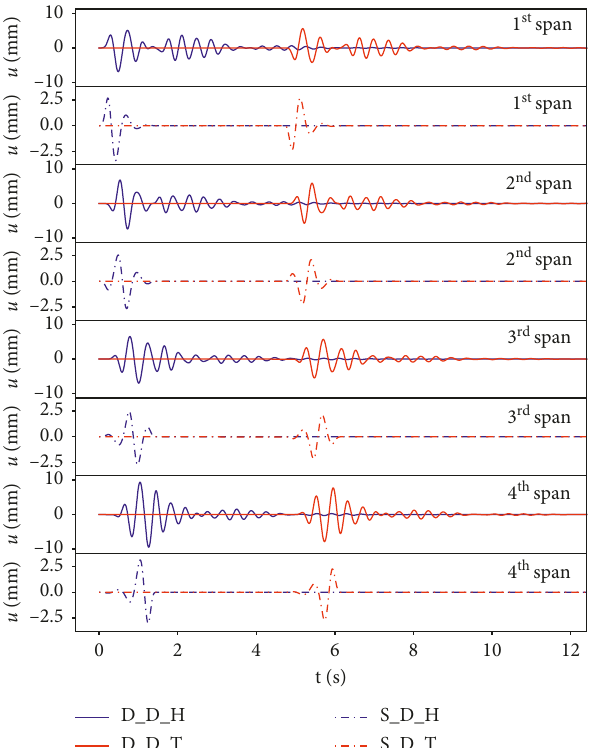
Figure 14: Central displacements of each span of the 4-span continuous purlin due to the high-speed train passing with speed 312.174km/h (S_D_H and S_D_Tstand for static displacements of the purlin due to the passing of head and tail, respectively; D_D_H and D_D_Tstand for dynamic displacements of the purlin due to the passing of head and tail,